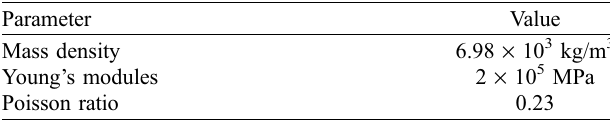
Table 1. The parameters of the material.